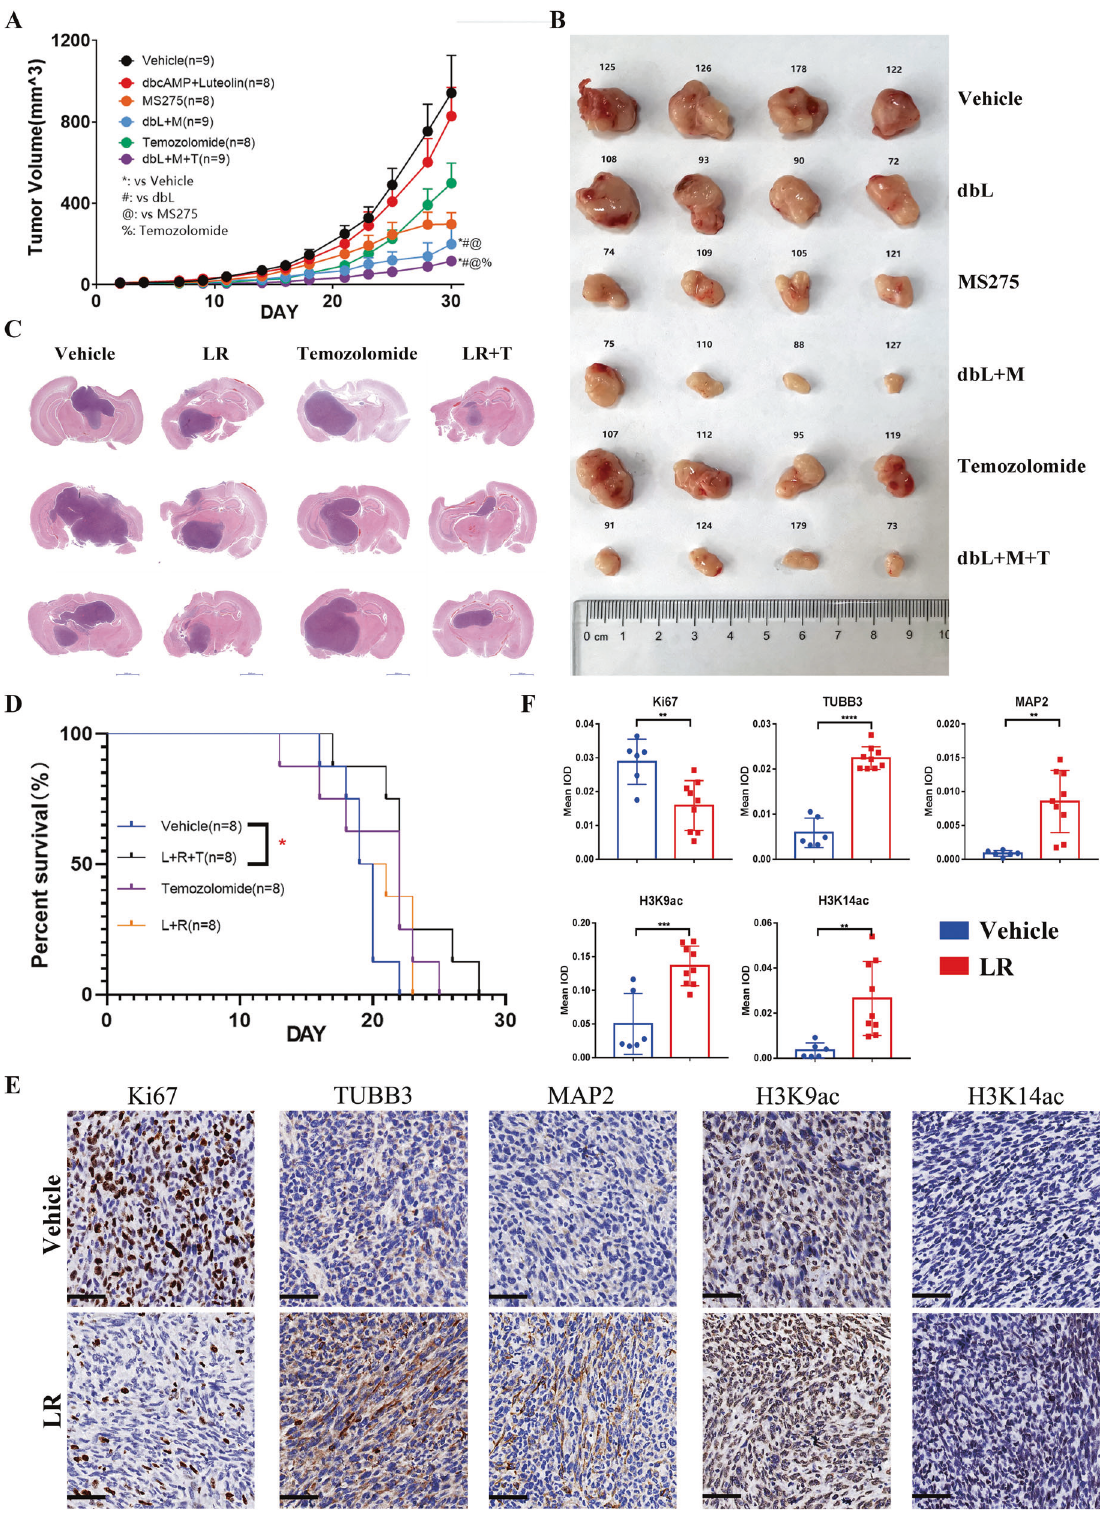
Flow cytometry analysis was performed on a Gallios fl ow cytometer (Beckman Coulter, USA). For cell proliferation assessment, the cells were incubated with 10 μ M EdU (Sigma-Aldrich) for 2 h, and EdU was chemically conjugated to 50 μ M Auto 488 (Sigma-Aldrich) for 1 h and incubated with